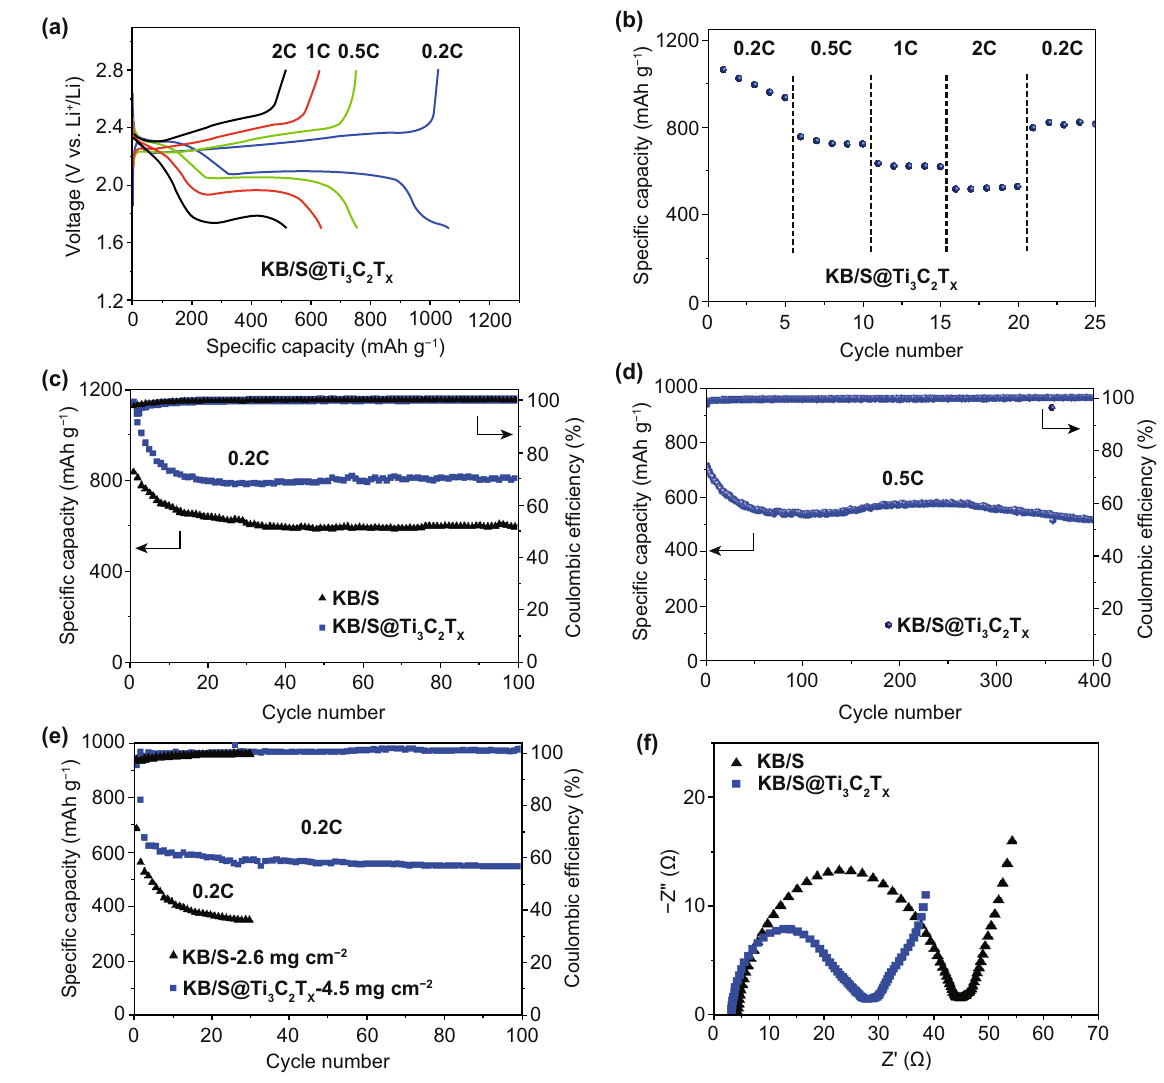
Fig. 3 a Voltage profiles of the KB/S@Ti 3 C 2 T x at various rates ranging from 0.2 to 2 C. b Rate performances of KB/S@Ti 3 C 2 T x . c Cycling per- formance of KB/S and KB/S@Ti 3 C 2 T x at 0.2C. d Long-term cycling of KB/S@Ti 3 C 2 T x at 0.5 C. e Cycling performance of KB/S and KB/S@ Ti 3 C 2 T x with high sulfur loading of 2.6 mg cm −2 and 4.5 mg cm −2 at 0.2 C, respectively. f Nyquist plots of the KB/S and KB/S@Ti 3 C 2 T x elec-